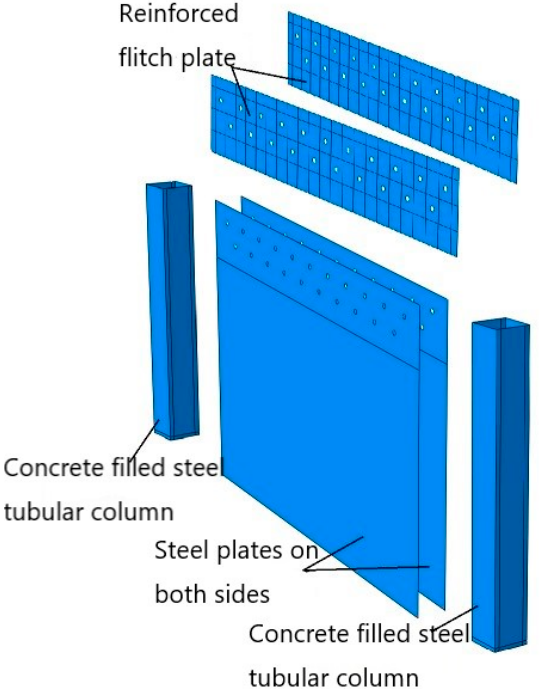
Figure 4. Description of components of lower shear wall unit.